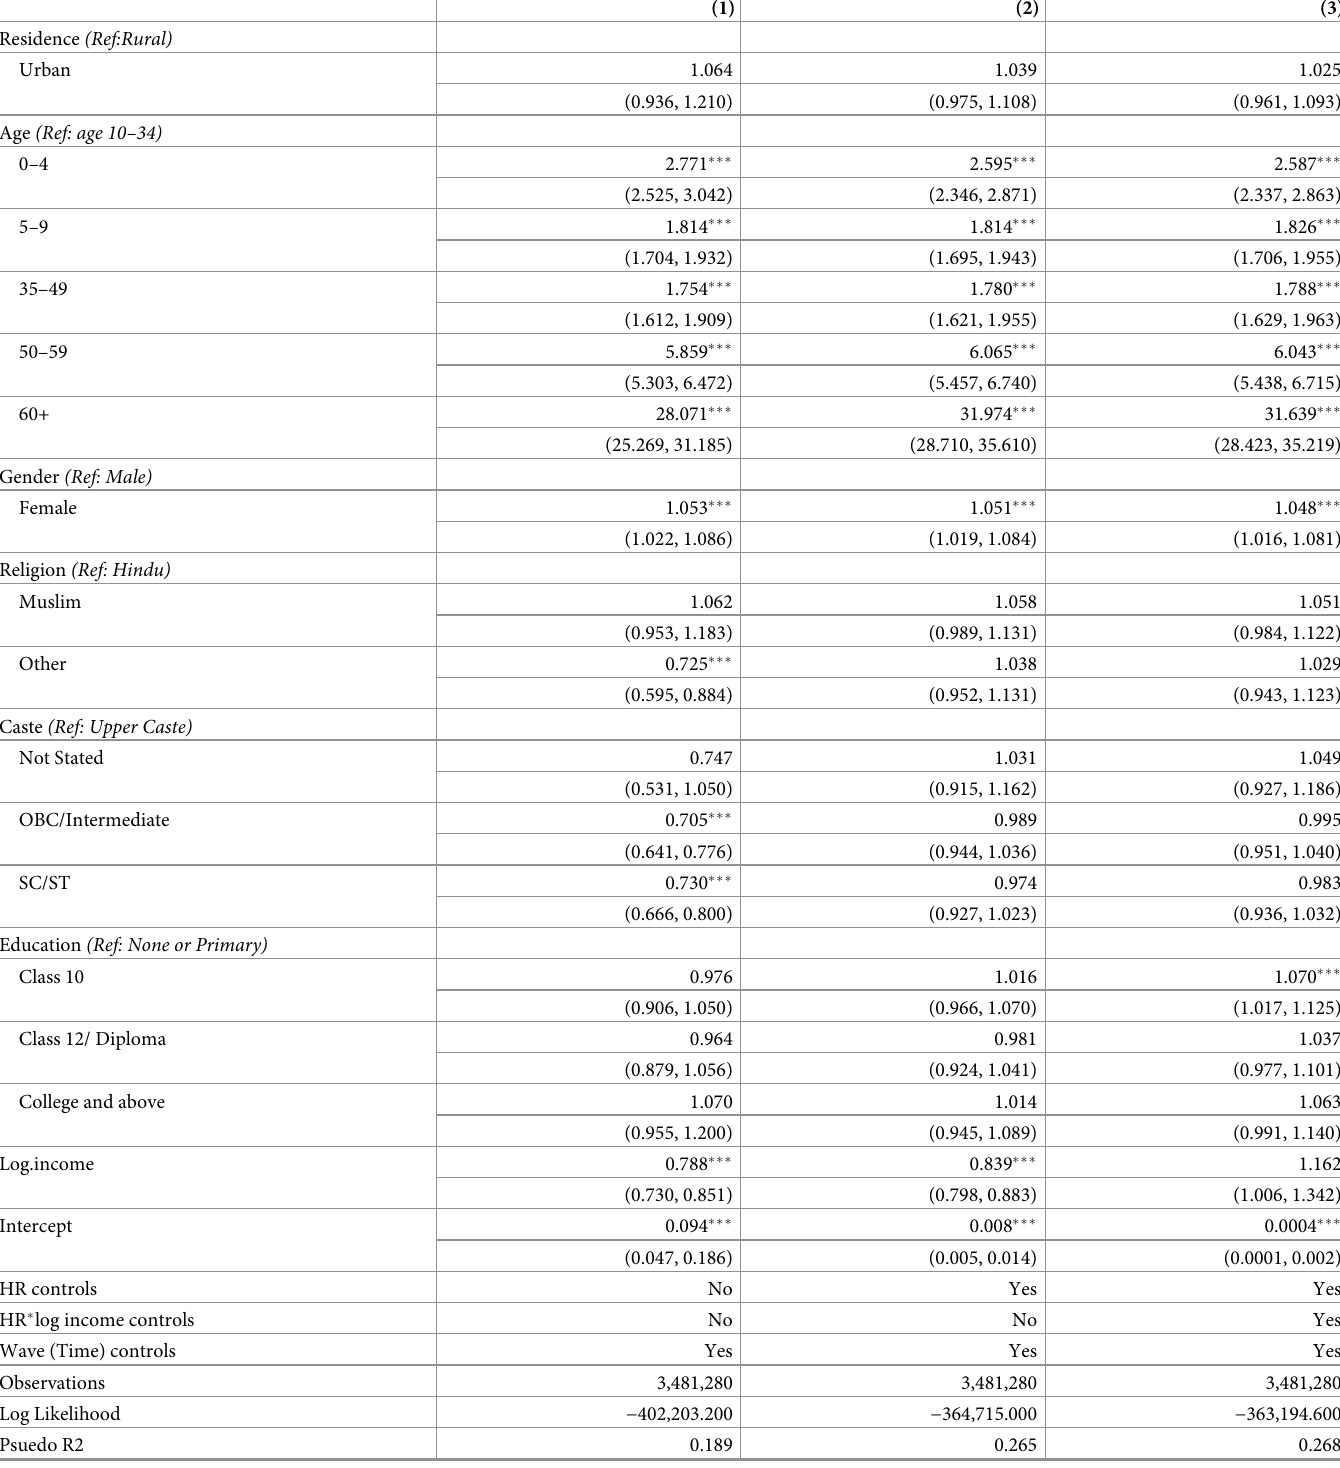
Table 2. Odds ratios from logistic regressions that predict self reported